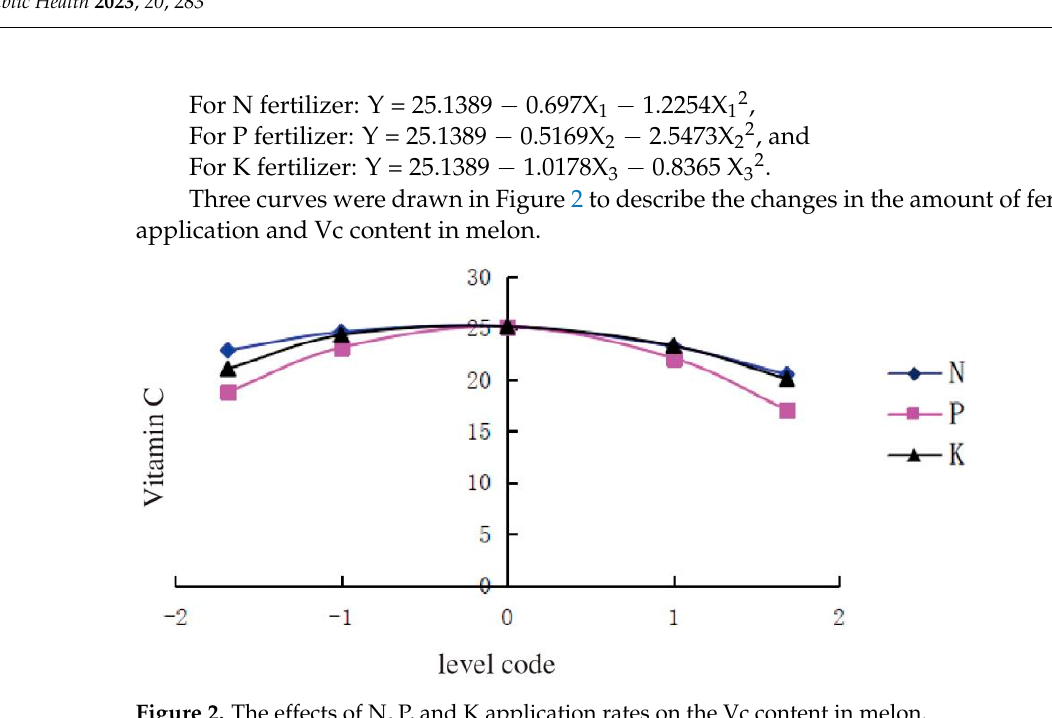
Figure 2. The effects of N, P, and K application rates on the Vc content in